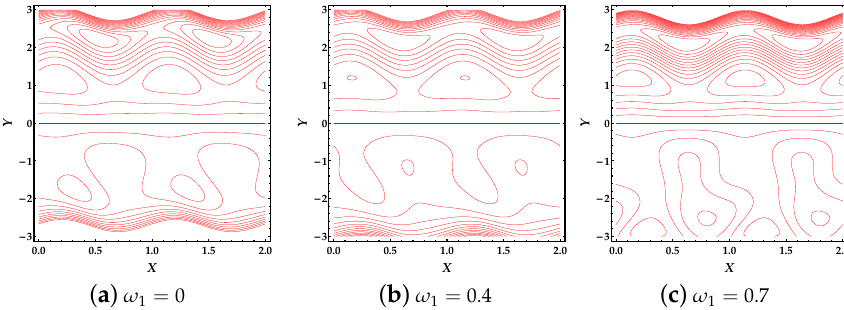
Figure 7. Streamline patterns against multiple values of ω 1 .